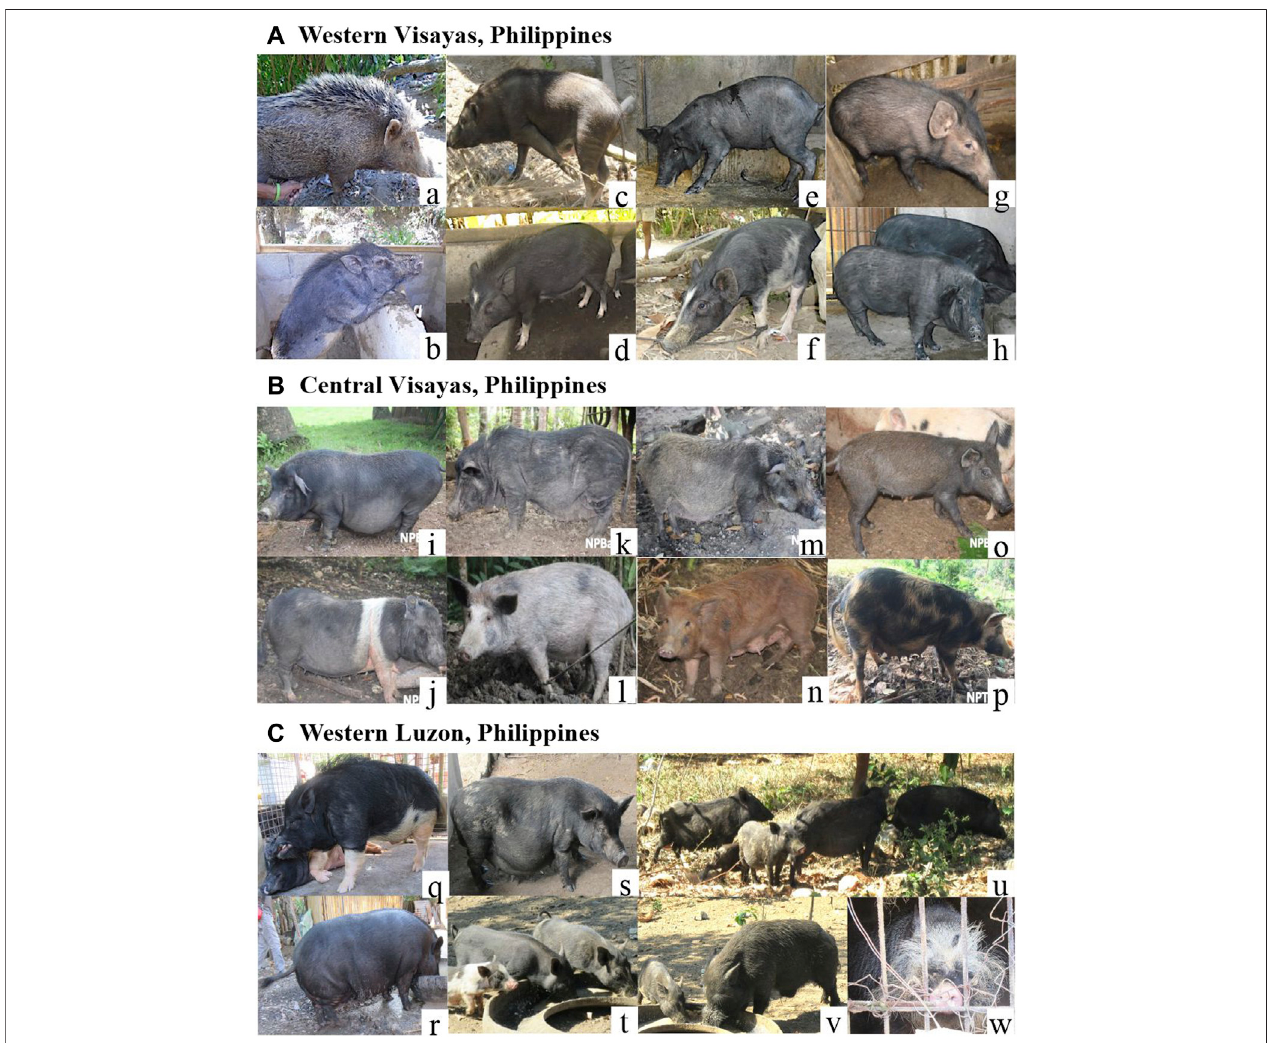
FIGURE 2 | Photographs of Philippine pigs across the Philippine islands and their raising system. (A) : (a) Bugasong, Antique; (b) Balderama, Antique; (c) Banga, Aklan; (d) Numancia, Aklan; (e) Dingle, Iloilo; (f) Conception, Iloilo; (g) Mambusao, Capiz; (h) Sapian, Capiz. (B) : (i) Balilihan, Bohol; (j) Bilar, Bohol; (k) Balilihan, Bohol; (l,m,n) Guindulman, Bohol; (o) Talibon, Bohol; ( p ) San Miguel, Bohol; (C) : (q) Irawan Village, Puerto Princesa, Palawan; (r) Sandoval Village, Narra, Palawan; (s) Puerto Princesa, Palawan; (t,u) Dumarao Village, Roxas, Palawan; (v) Sandoval Village, Narra, Palawan (crossed endemic Sus ahoenobarbus with native pigs); (w) Sus ahoenobarbus (a wild pig endemic to Palawan Faunal